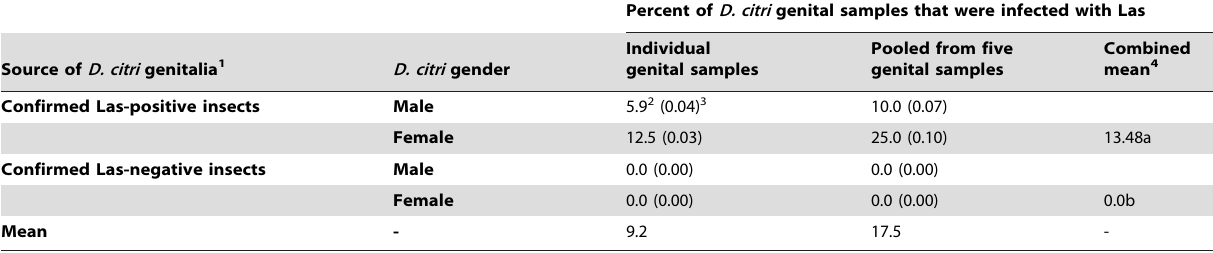
Percent of D.citri genital samples that were infected with Las